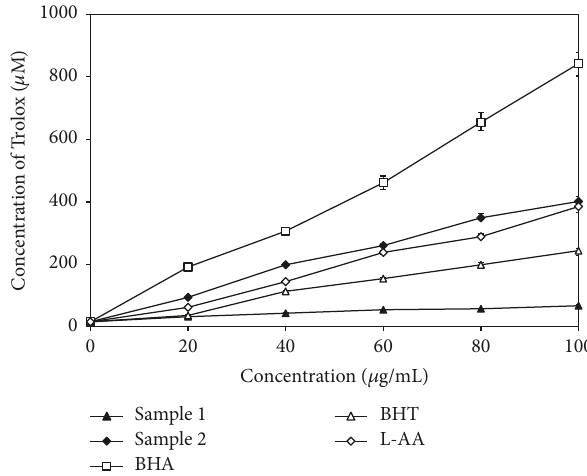
Figure 2: Free radical-scavenging activity of extracts from C. multiflorus sarcocarp measured by ABTS assay. Results are mean ± SD ( 𝑛 = 3 ). Sample 1: the sample extracted by ethanol-water (7 :3, v/v);Sample2:thesamplereextractedfromSample1byethylacetate.